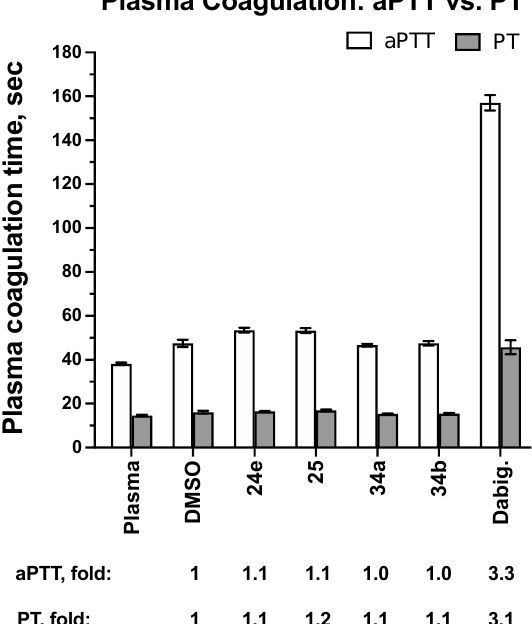
Figure 5. The influence of compounds on plasma coagulation (in vitro). Selected acylated 1 H - pyrazol-5-amines were tested at 200 µ M and dabigatran ( 1 ) was tested at 2 µ M. The activated partial thromboplastin time (aPTT) and prothrombin time (PT) are shown in sec. The fold increase in aPTT and PT compared to the effect of DMSO is shown under the diagram. Tests were performed at least in triplicate, and the average with standard deviation (SD) is given.